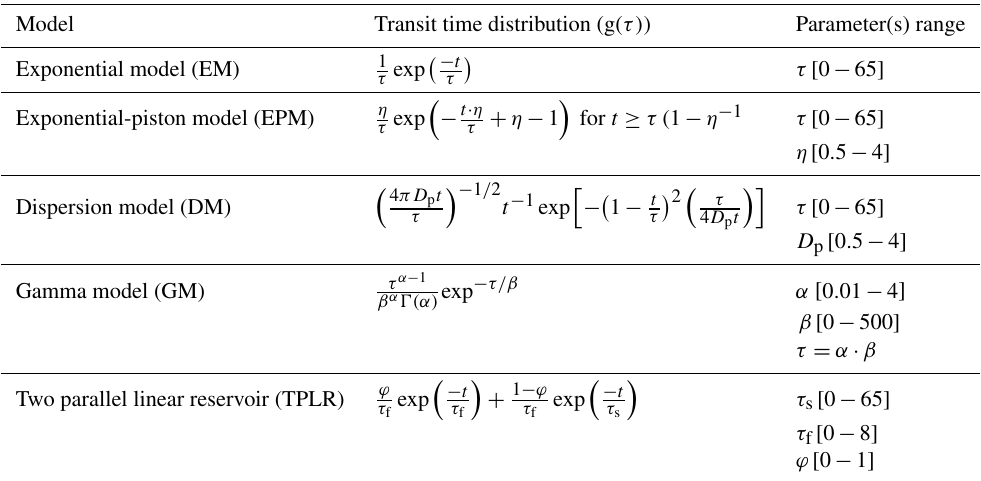
Table 2. Models considered to describe water mean transit time (MTT) in the study area and their transit time distribution (TTD) functions, parameters, and range of initial